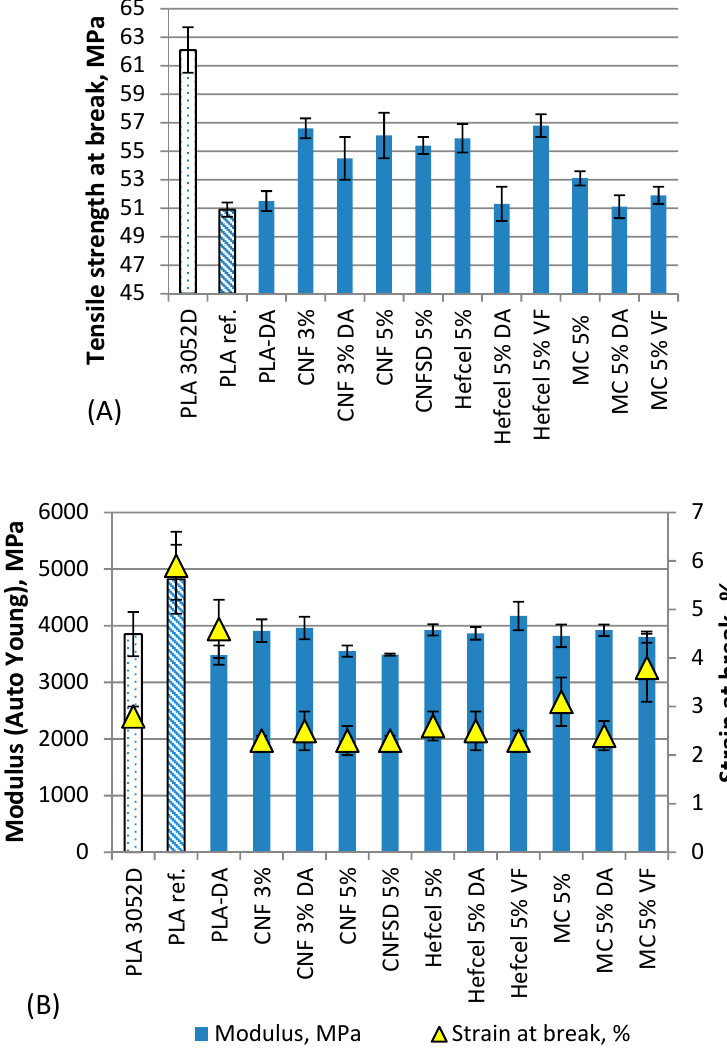
Figure 6. Tensile strength results ( A ), and modulus and strain at break ( B ) for injection molded PLA composites.